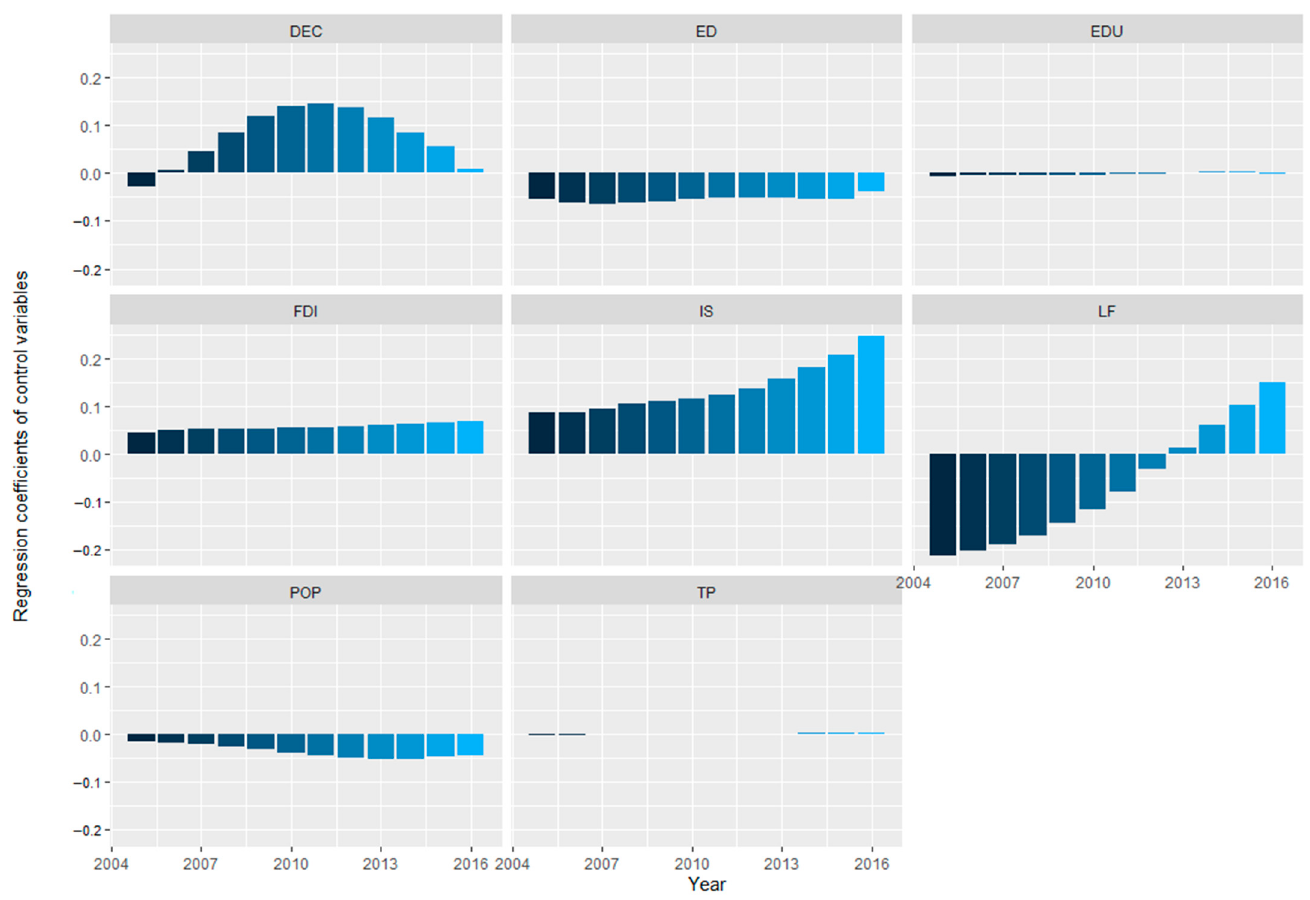
Figure 10. Regression coefficients of control variables.